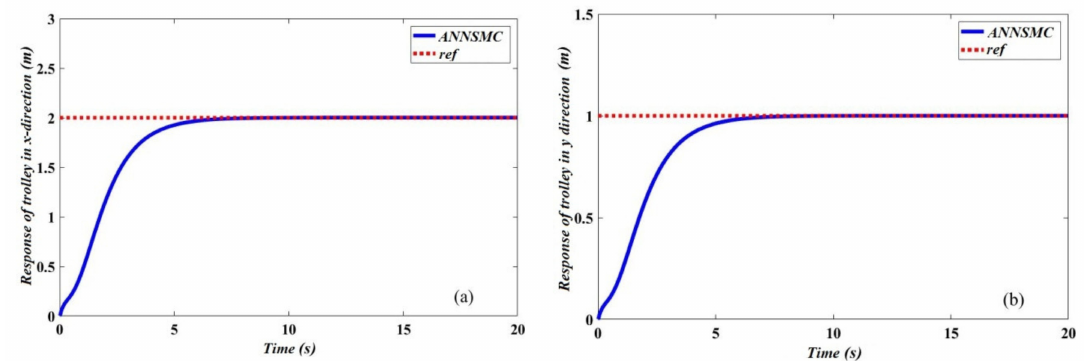
Figure 6. The trolley position when the payload mass is 20 kg.